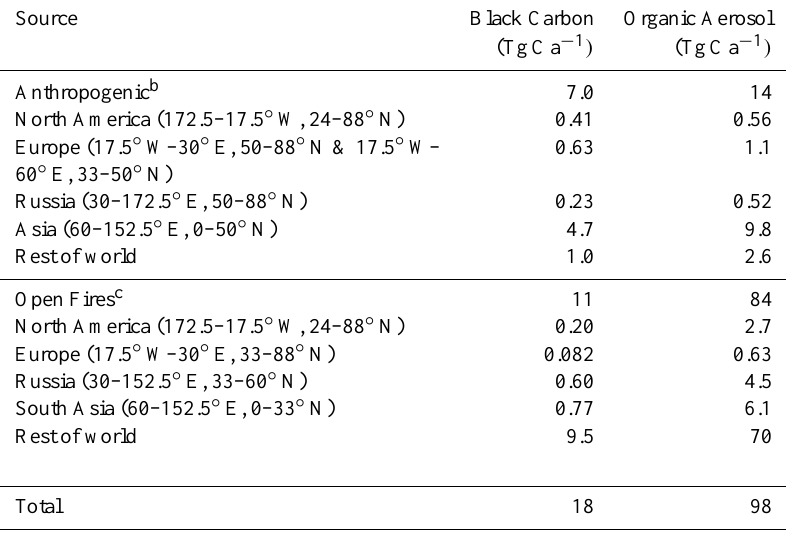
Table 1. Global GEOS-Chem emissions of carbonaceous aerosols in 2008 a . Source Black Carbon